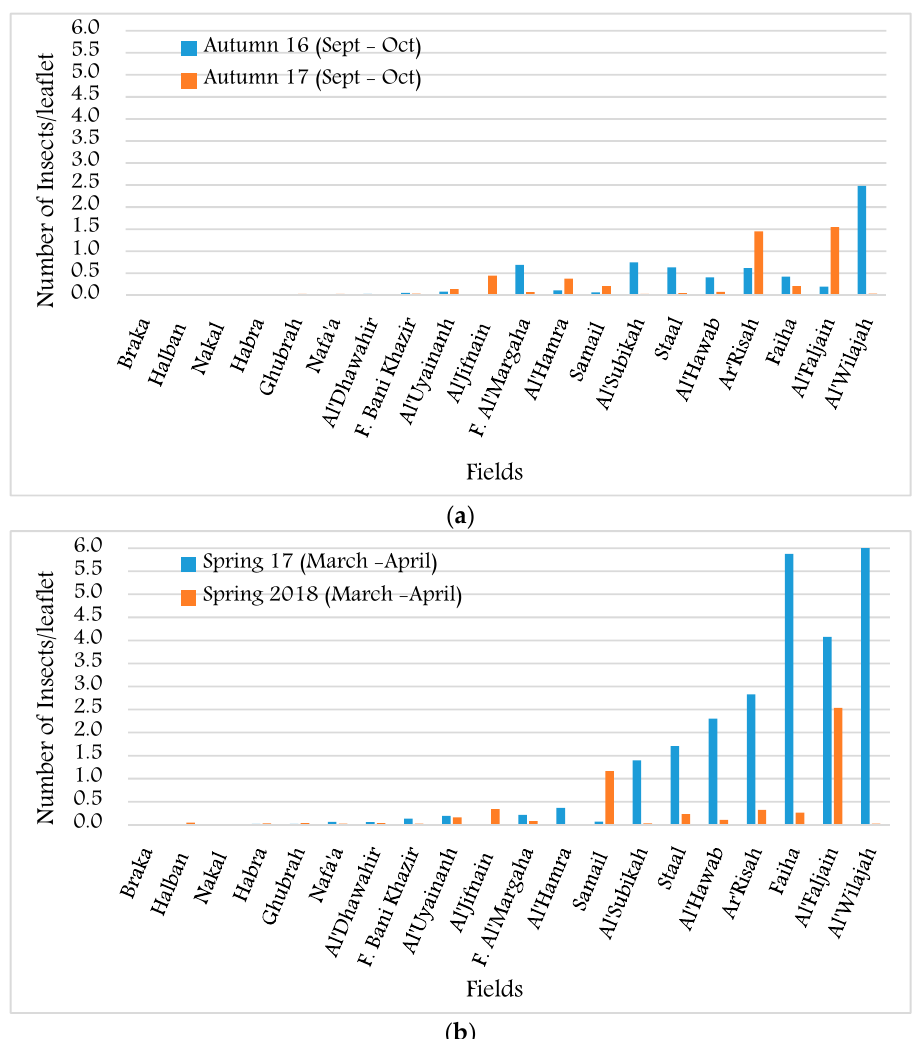
Figure 2. Average number of O. lybicus , infestations in each field for the autumns of 2016 and 2017 ( a ) and springs of 2017 and 2018 ( b ).